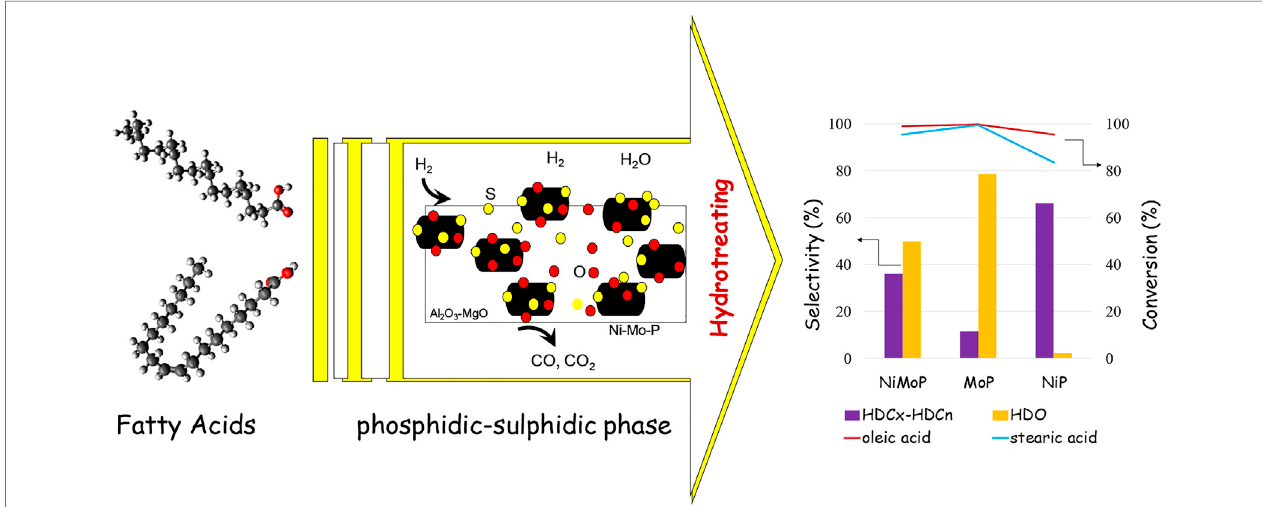
GRAPHICAL ABSTRACT | The sulfur and metal-type content in MoP-S/ γ -Al 2 O 3 -MgO, NiMoP-S/ γ -Al 2 O 3 -MgO, and NiP-S/ γ -Al 2 O 3 -MgO in fl uence the reaction pathways for hydrotreating fatty acids, improving the dispersion of MoS 2 on phosphide “ mixed phosphidic-sulphidic species ” and increasing the number of Lewis and Brönsted sites, which correlates well with the HDO and HDCx-HDCn